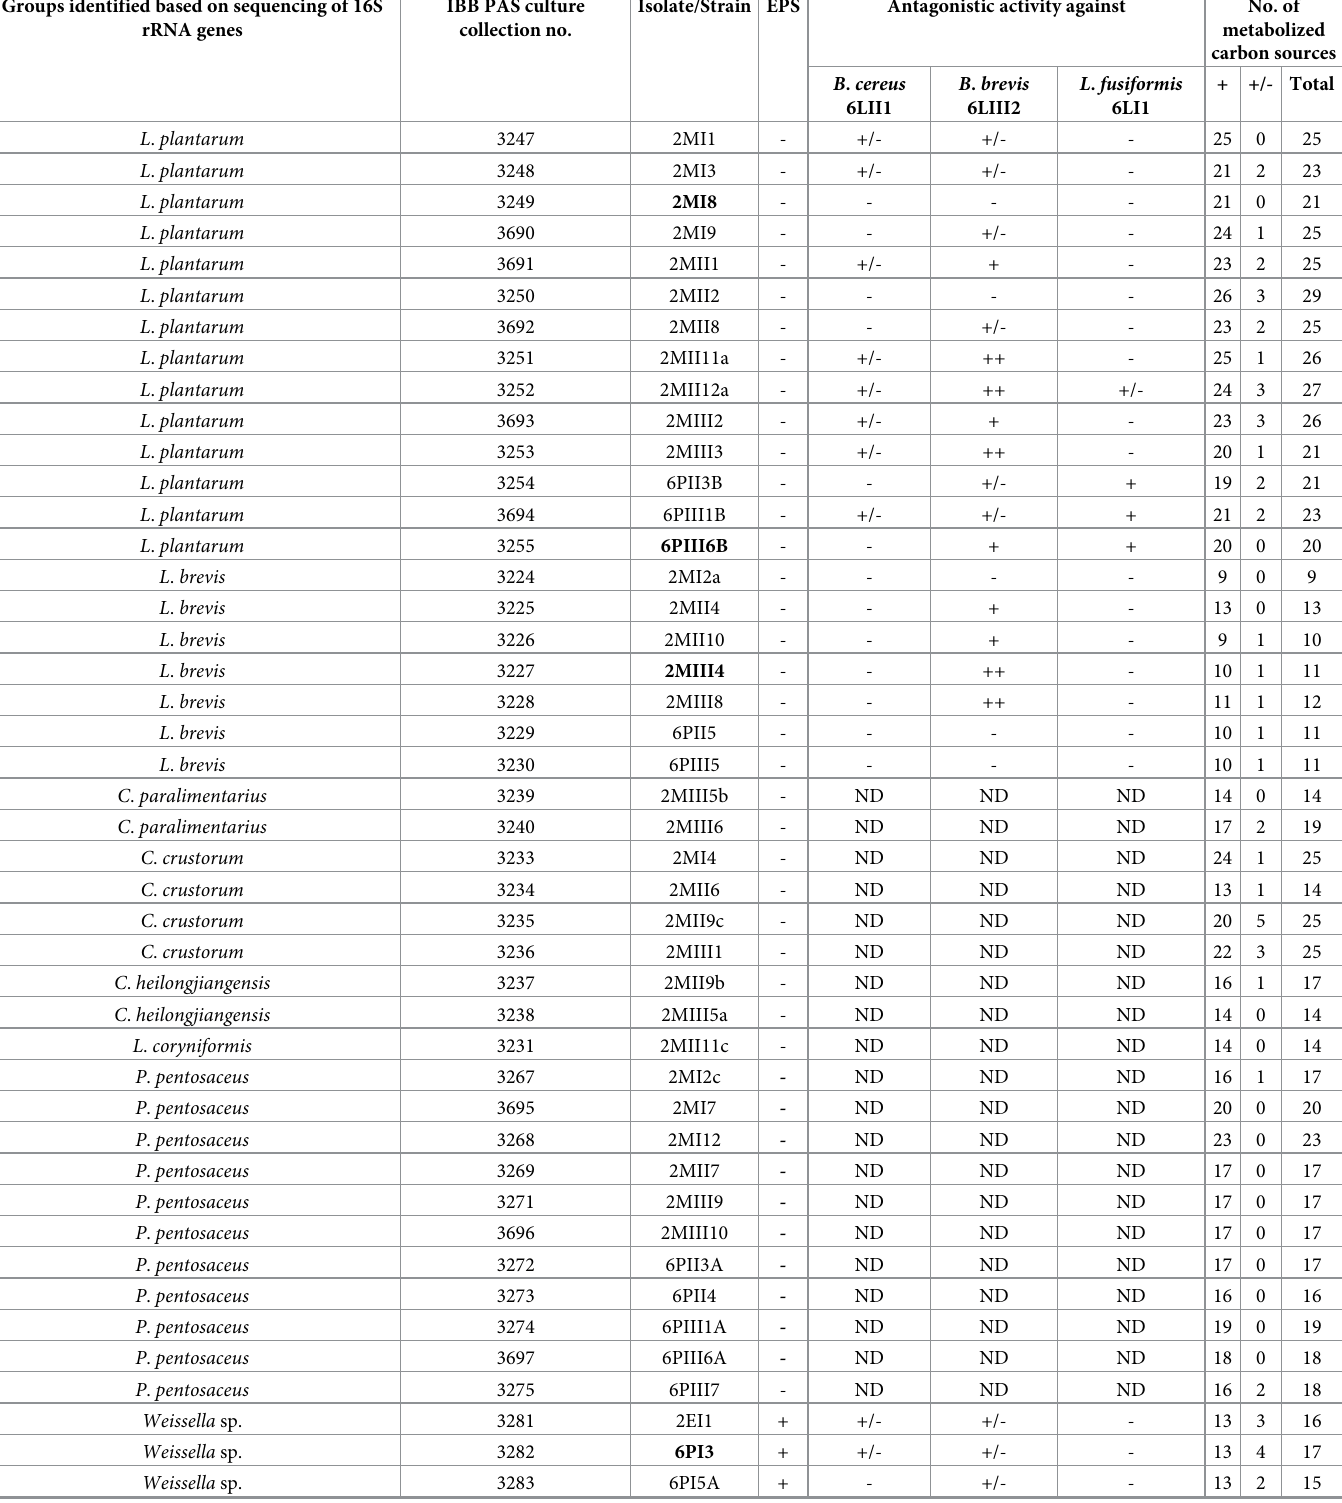
Table 2. Phenotypic characterization of LAB strains isolated from rye wholemeal sourdoughs. Groups identified based on sequencing of 16S rRNA